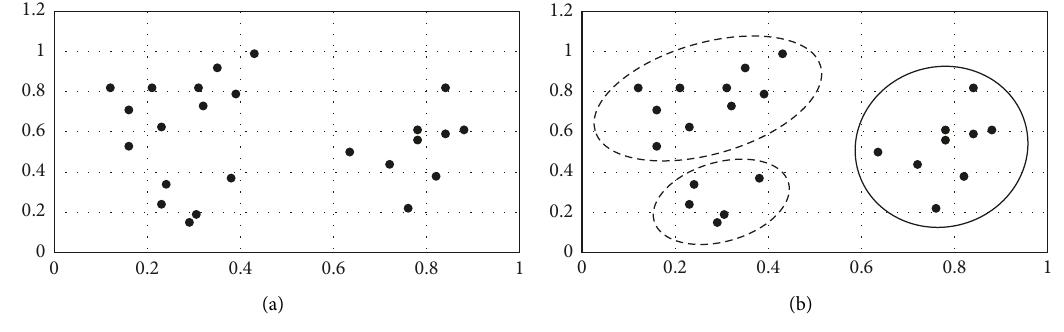
Figure 2: The basis of K-means algorithmic clustering.